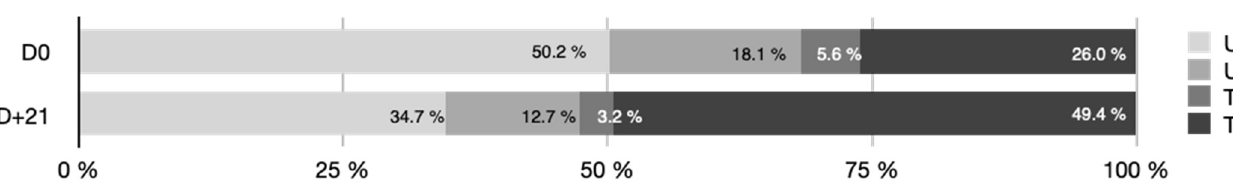
Figure 3. Dispersion by measurement time of judgments about the system, categorized according to the role taken and the valence of the response (SHERPAM project).